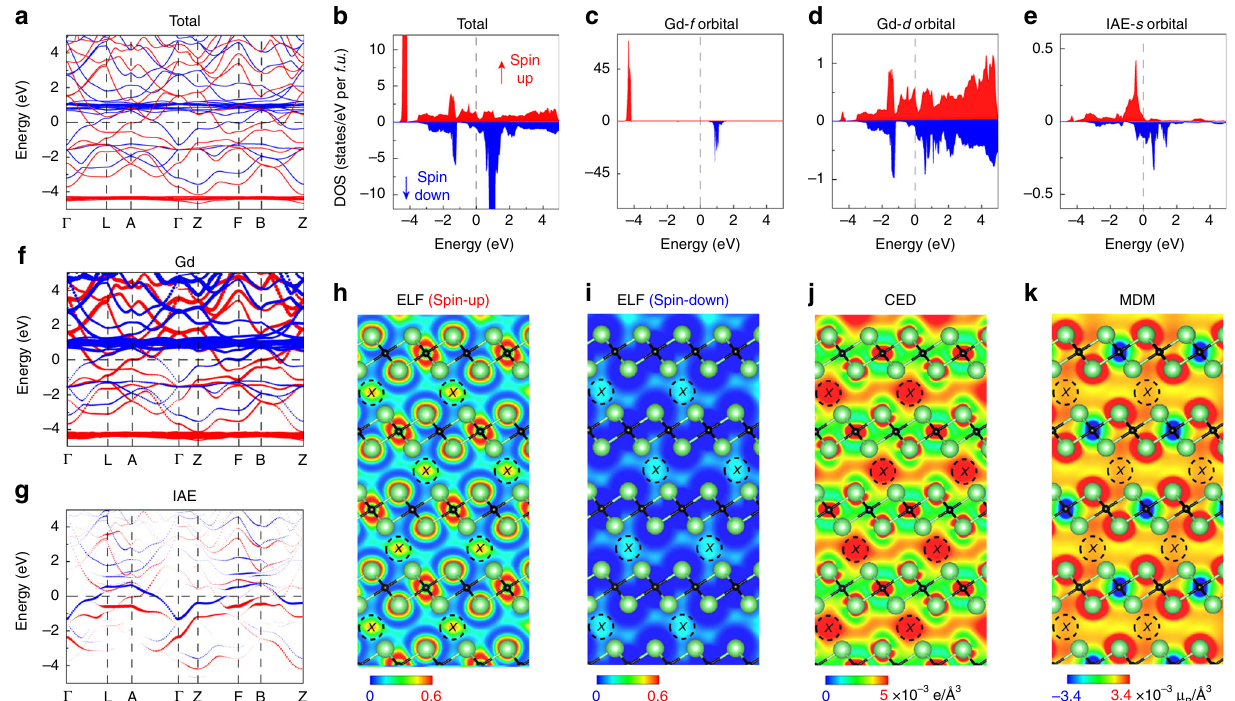
Fig. 3 Quasi-atomic IAEs in FM [Gd 2 C] 2 + ·2e − electride. a , b Band structure and total DOS (red: spin-up; blue: spin-down). E F is set to zero energy (dashed line). c – e Projected DOS on Gd- f orbital ( c ), Gd- d orbital ( d ), and IAE- s orbital ( e ). f , g The projected band structures on Gd atom ( f ) and IAE ( g ). h , i ELF for spin-up and spin-down states. “ X ” in the dashed circle denotes the site of IAEs, which is 6 c (0, 0, 0.5) in the R (cid:1) 3 m space group. j CED map ( − 1.0 eV < E < 0 eV). k MDM. IAEs are strongly localized at “ X ” sites ( h , i ), contributing to a dispersion band crossing E F ( j ) and exhibiting a distinct magnetic spin density ( k